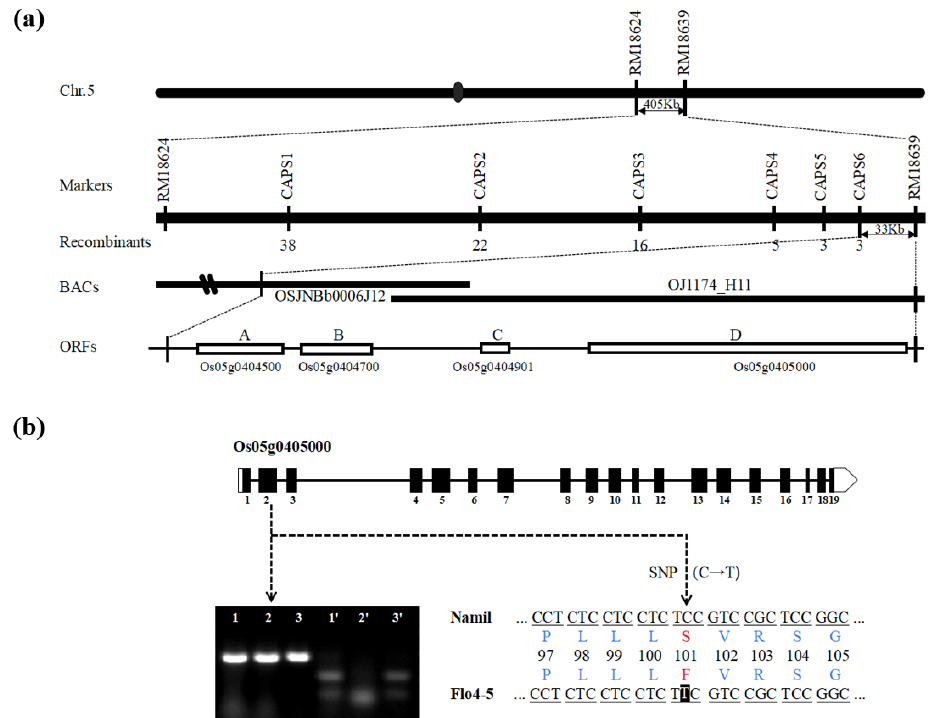
Figure 2. Map-based cloning of the flo4-5 mutant. ( a ) Fine mapping of the flo4-5 locus. The molecular markers and number of recombinants are shown. The 33kb virtual contig, composed of overlapping 2 BAC clones, was delimited by e-Landings of two significant markers on the reference rice genome, ‘Os-Nipponbare-Reference-IRGSP-1.0’; ( b ) flo4-5 gene structure and cDNA sequence comparison showing a nucleotide mutant (C to T) within exon 2 where Ser-101 of the wild was induced to Phe-101 of the flo4-5 . White boxes represent untranslated regions, black boxes represent coding regions, and solid lines represent introns. 1,2,3 are the PCR results of wild type Namil, flo4-5 (Namil (SA)–flo1) and flo4-4 (Namil (SA)–flo2), respectively. 1’, 2’, 3’ are the digested results.